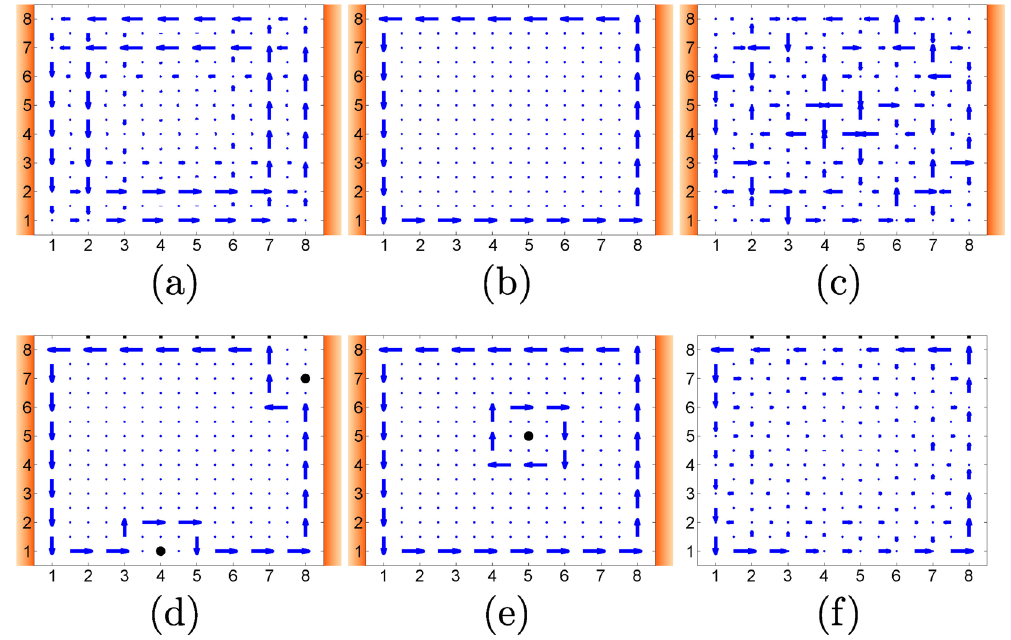
Figure 2. Current patterns for the system in contact with thermal baths at the same temperature T h = T c = T : ( a ) for T = 4 K, ( b ) for T = 2500 K, and ( c ) for T = 10 15 K; and under the presence of different defects represented with a black dot in ( d ) and ( e ) for T = 2500 K. In ( f ) the pattern for an individual excited edge mode is depicted. For the sake of illustration the magnitude of the currents has been normalized in every subplot, see main text for specific